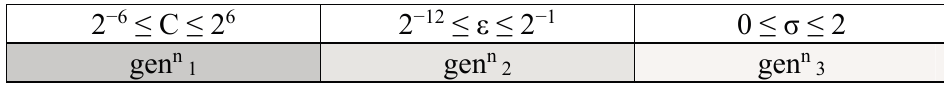
Table 2. An example of chromosome encoding.